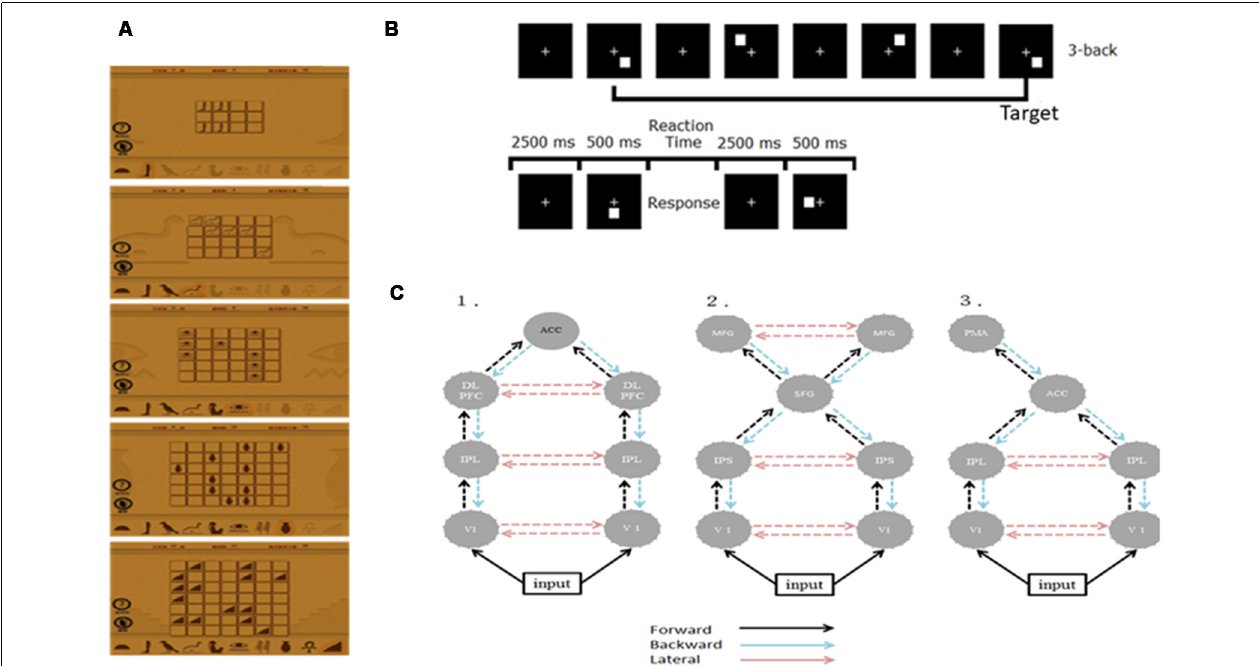
FIGURE 1 | (A) Illustration of the training material. (B) The experimental paradigm of the 3-back task. (C) Architectures of the three plausible DCMs. ACC, anterior cingulate cortex; DLPFC, dorsolateral pre-frontal cortex; IPL/S, intraparietal lobe/sulcus; V1, primary visual cortex; MFG, middle frontal gyrus; SFG, superior frontal gyrus; PMA, premotor